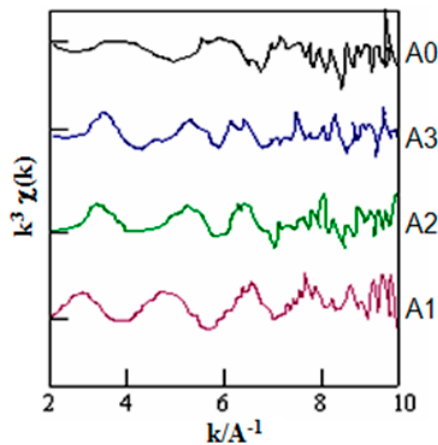
Figure 17. Extended X-ray absorption fine structure (EXAFS) of three EDFs (A1, A2, and A3) containing different contents of Al 2 O 3 and Er 2 O 3 , along with one EDF sample without Al 2 O 3 (A0).